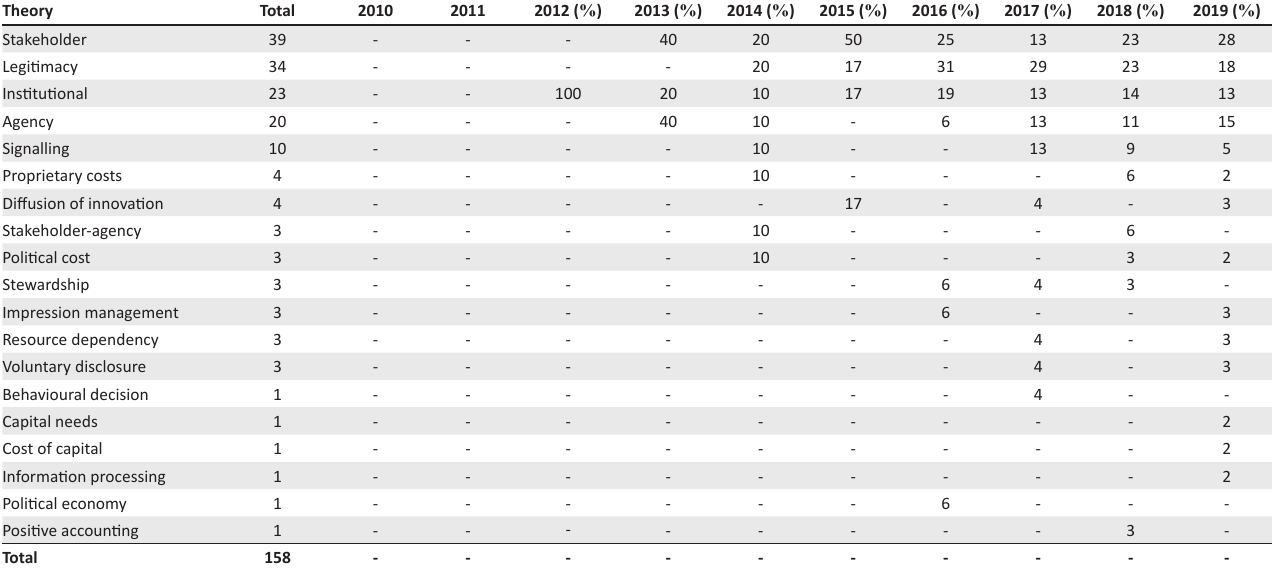
TABLE 3: Occurrence of each theory in integrated reporting literature in total, and as a percentage of the total per year.